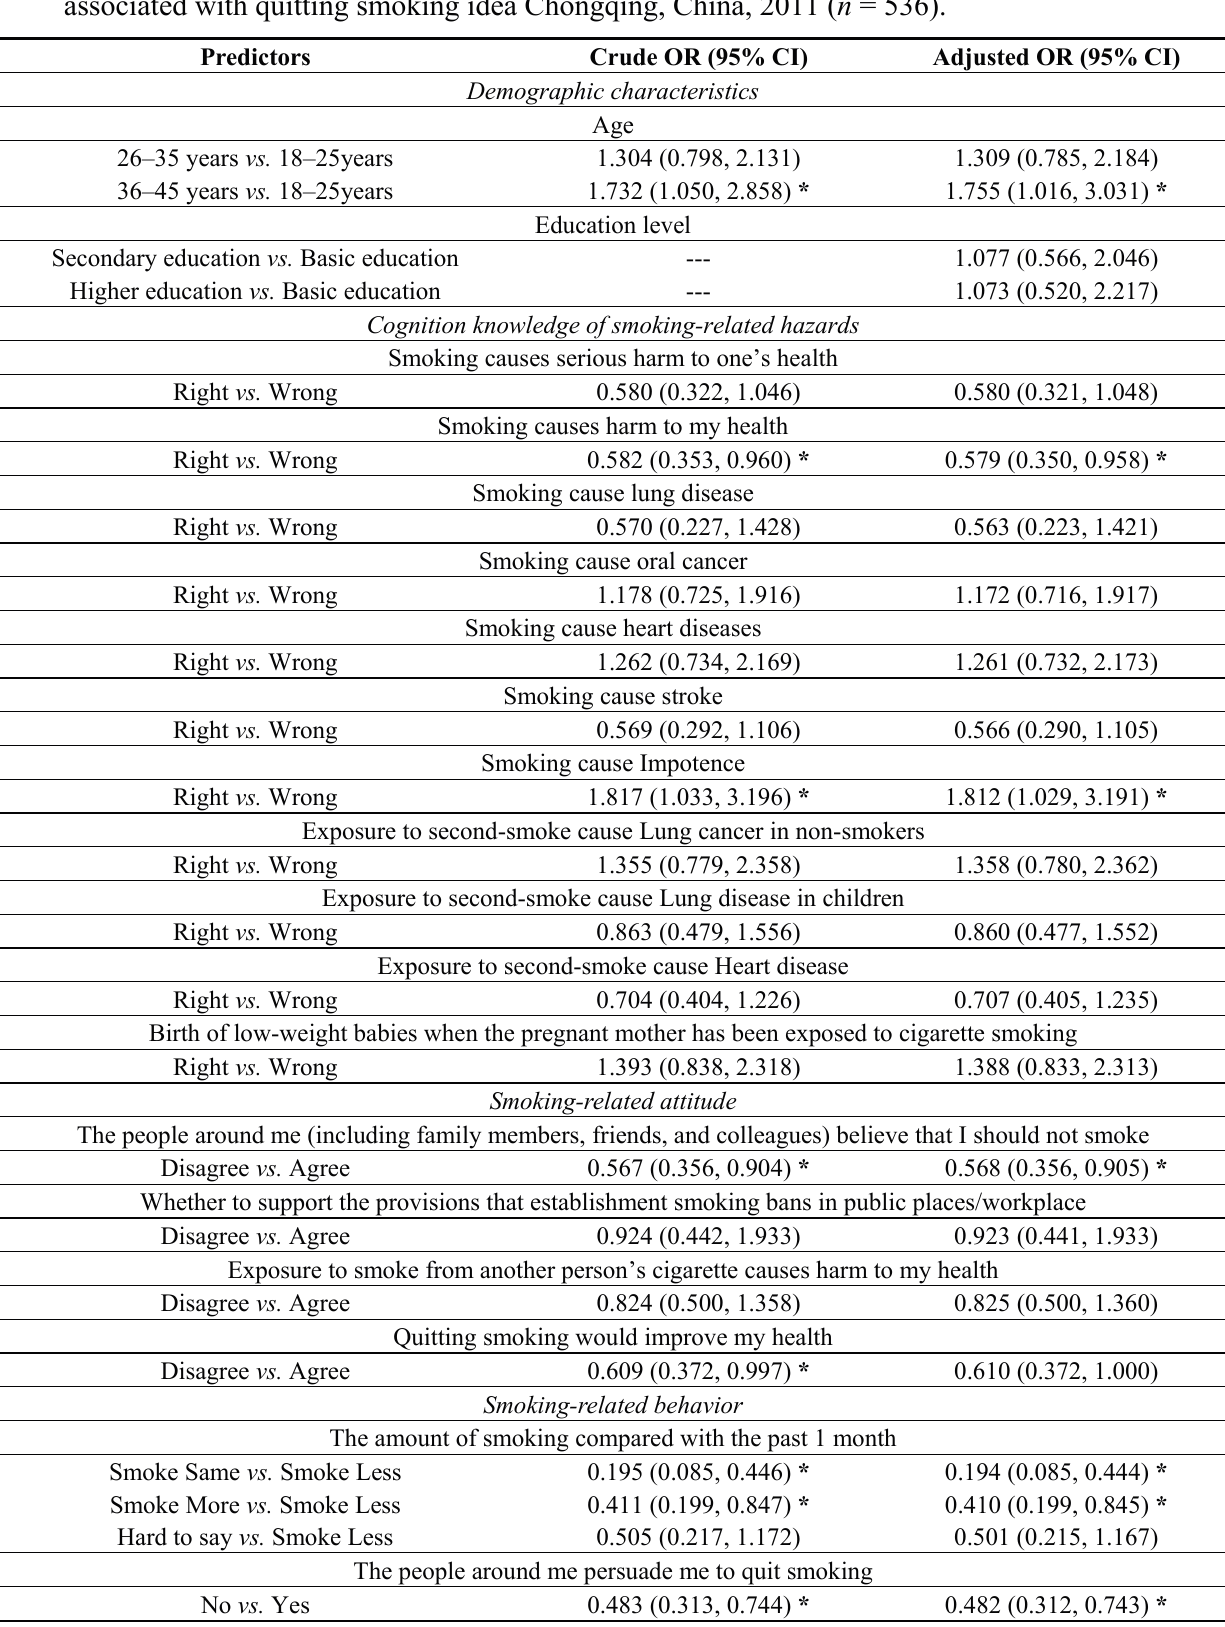
Table 6. Smoking-related knowledge, attitudes, behaviors and sociodemographic factors associated with quitting smoking idea Chongqing, China, 2011 ( n =